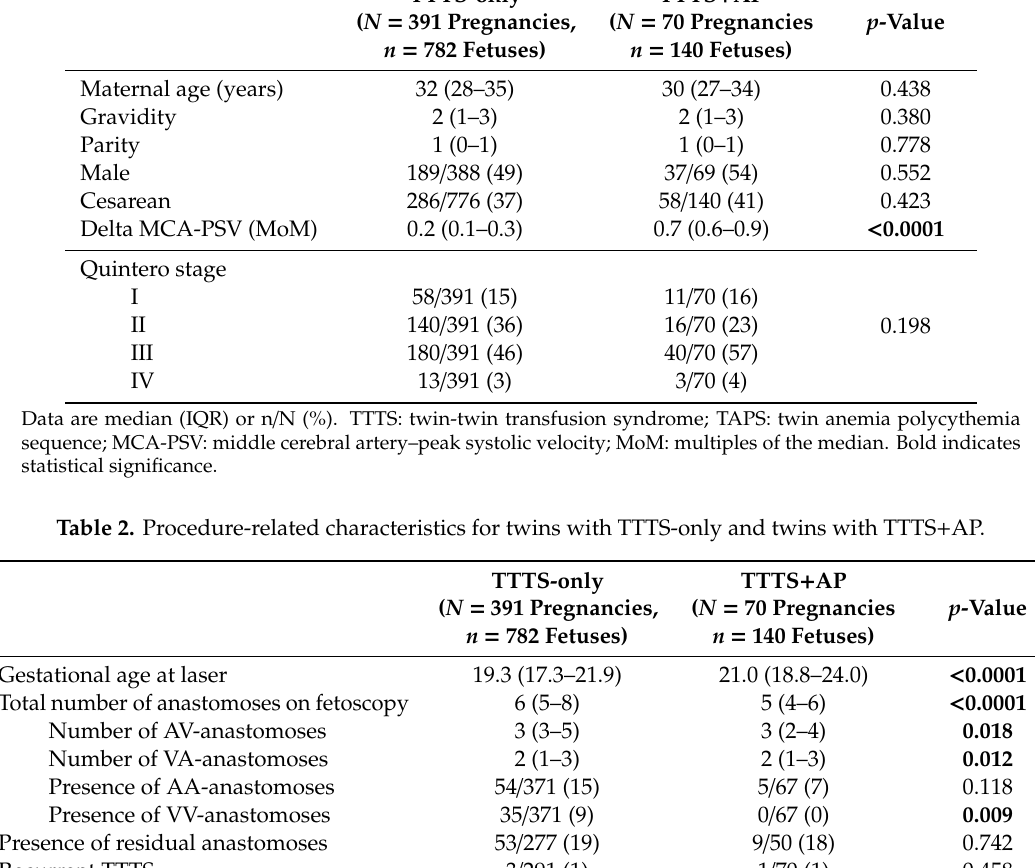
Table 1. Baseline characteristics for twins with TTTS only and TTTS + AP (anemia-polycythemia) twins. TTTS-only